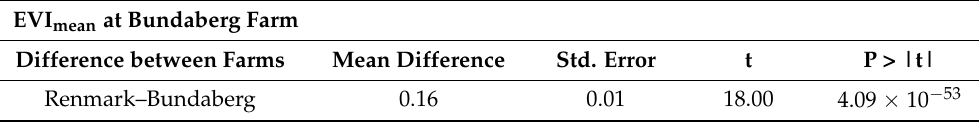
Table 4. Tukey-HSD test between the Bundaberg and Renmark avocado farms. EVI mean at Bundaberg Farm Difference between Farms Mean Difference Std. Error t P > |t| Renmark–Bundaberg